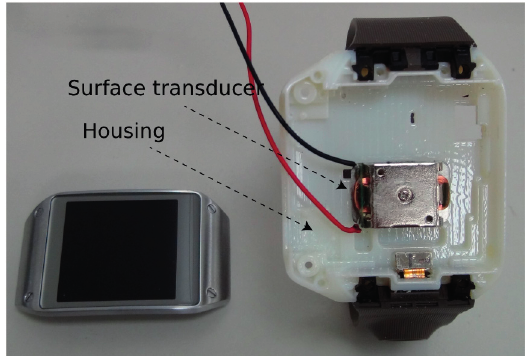
Figure 3. Internal view of the proposed system. A surface transducer is firmly mounted to the custom Galaxy Gear I